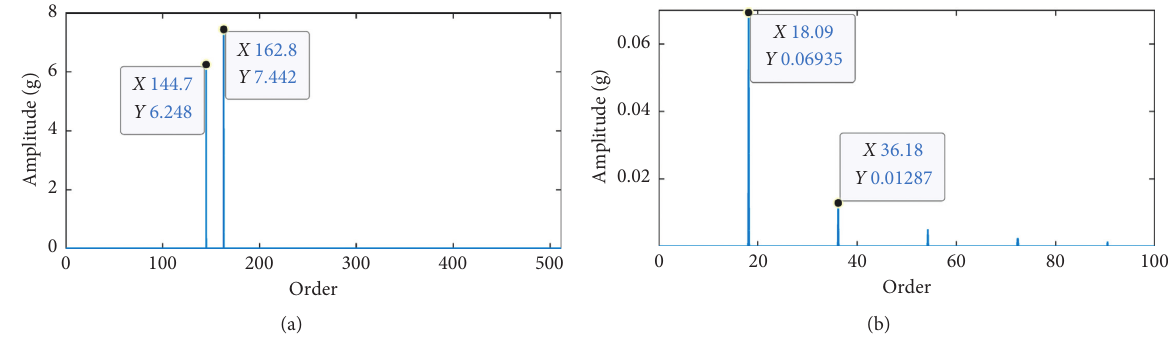
Figure 26: The extracted result of inner race fault using CS-based on MCM: (a) the detected sparse coefficients and (b) the visualized envelope order